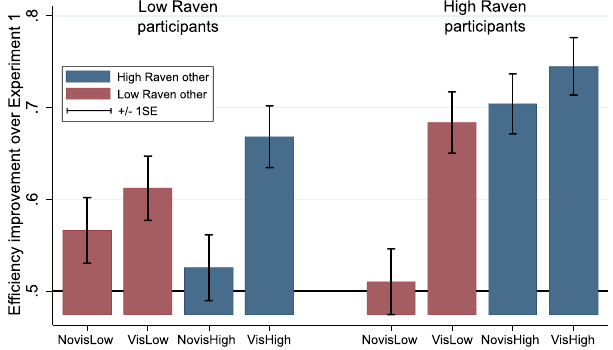
Figure 3. Efficiency improvements over Experiment 1. The bars show the proportion of periods in which the average efficiency in Experiment 2 (by treatment and Raven score of participants) exceeds average efficiency in Experiment 1 (both smoothed by 5-period moving average). The bar colours stand for the Raven score of the observed other. Ranges are ± 1